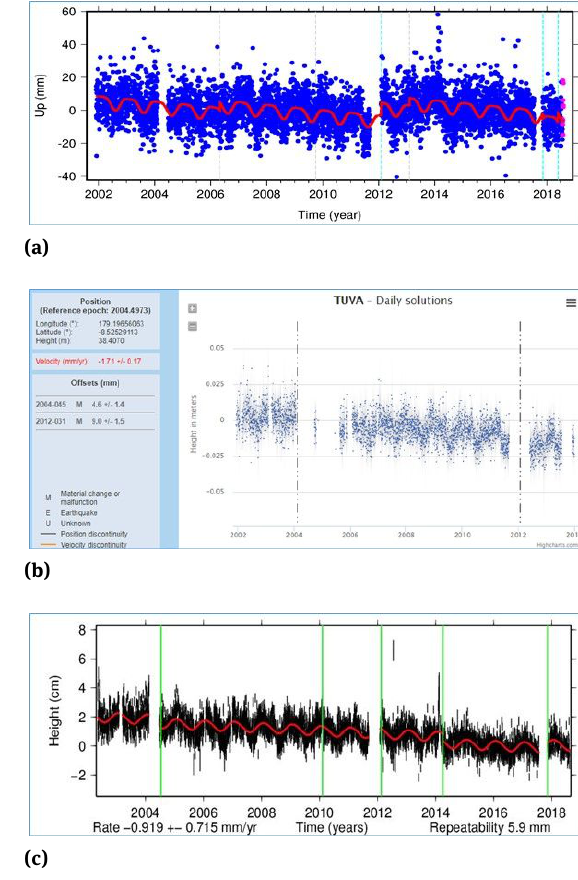
Figure 13: Vertical position of the TUVA GPS antenna (a) according to NGL, Image modified after NGL; (b) according to SONEL, Image modified after SONEL; (c) according to JPL, Image modified after